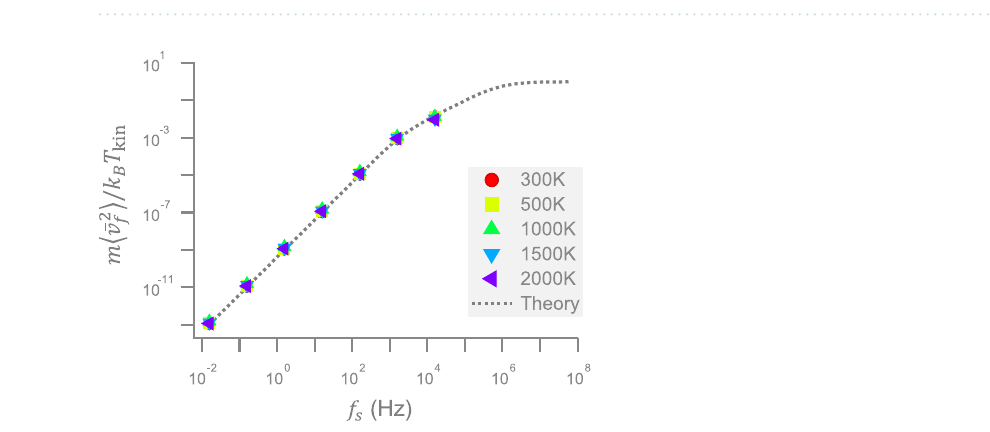
Figure 2. The PDFs of the position fluctuations ( a ) and of the velocity fluctuations ( b ), as well as the corresponding power spectrum densities ( c ) for an increasing virtual stiffness, k v , (blue arrow) at a fixed virtual 0 , (or T kin T R ). ( d ) A comparison between the assigned stiffness, k v , and the measured temperature, T v = = stiffness, k eff . The symbols in ( a ), ( b ), and ( c ) have the same k v values as the symbols of the same colors in ( d ). k ot , ( e ), ( f ), and ( g ) are similar to ( a ), ( b ), and ( c ), but for an increasing T v (red arrows) at a fixed stiffness, k v = 0 . ( h ) A comparison between the assigned temperature, T kin , and the measured which corresponds to α = T v T R values as the symbols of the temperature, T eff . The symbols in ( e ), ( f ), and ( g ) have the same T kin = + same colors in ( h ). While the symbols in ( a ), ( b ), ( c ), ( e ), ( f ), and ( g ) are experimental values, the lines in ( a ), ( b ), ( e ) and ( f ) are fitting functions and those in ( c ) and ( g ) are theoretical functions given by Eq. (3). The slopes of the solid lines in ( d ) and ( h ) are 1.